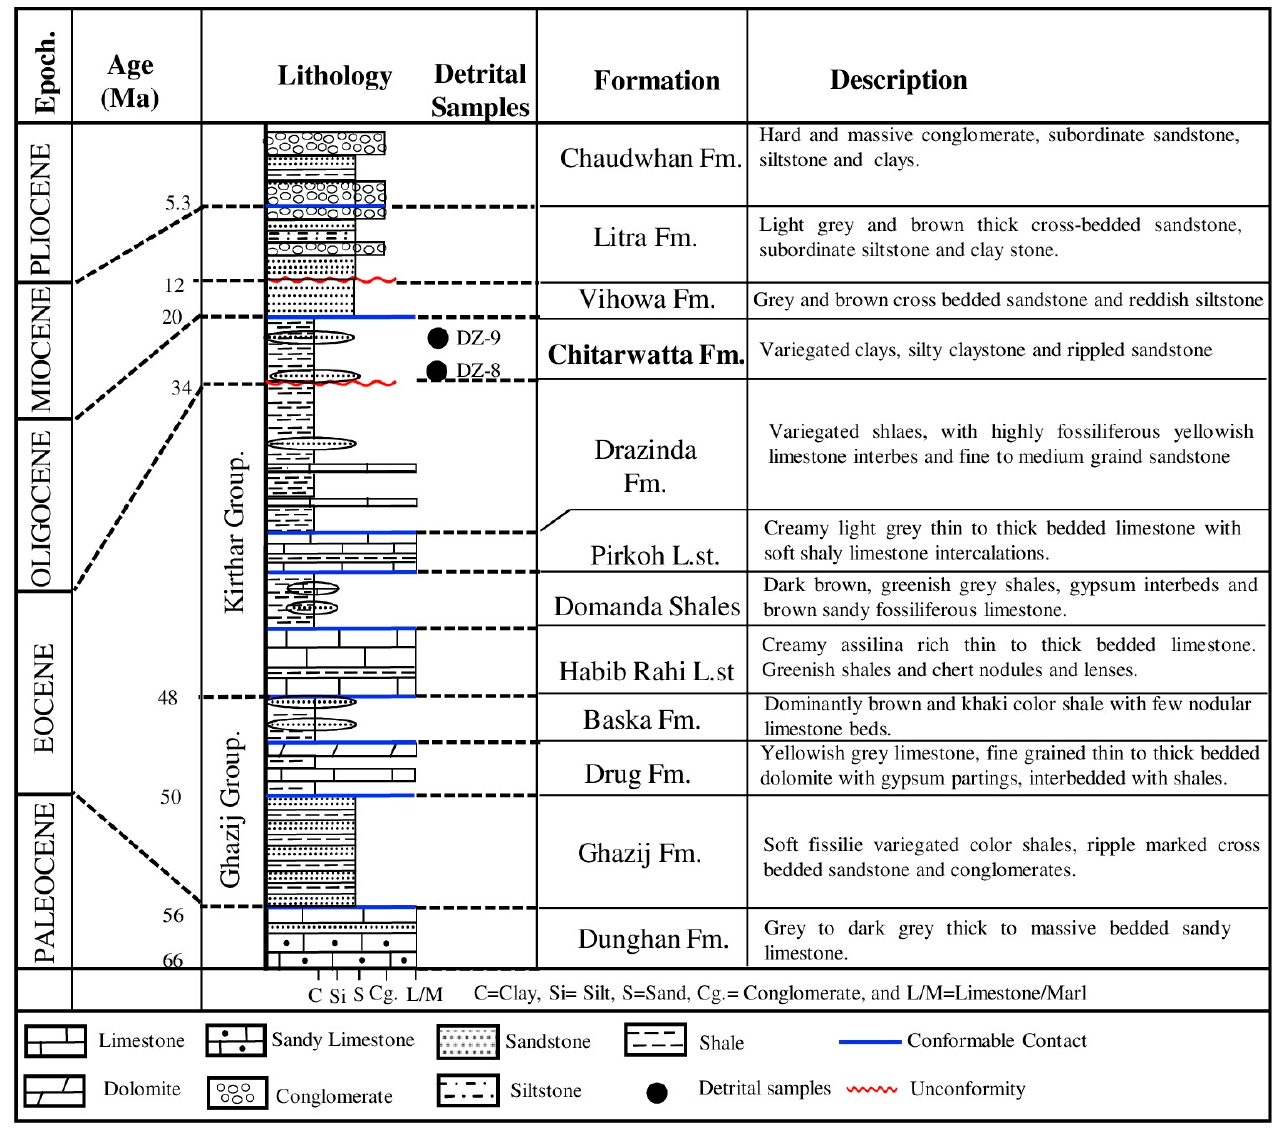
Figure 2. Generalized lithostratigraphic column of the Mughalkot section, Sulaiman fold–thrust belt showing lithologies of the various stratigraphic units and stratigraphic position of the col- lected samples [21] .